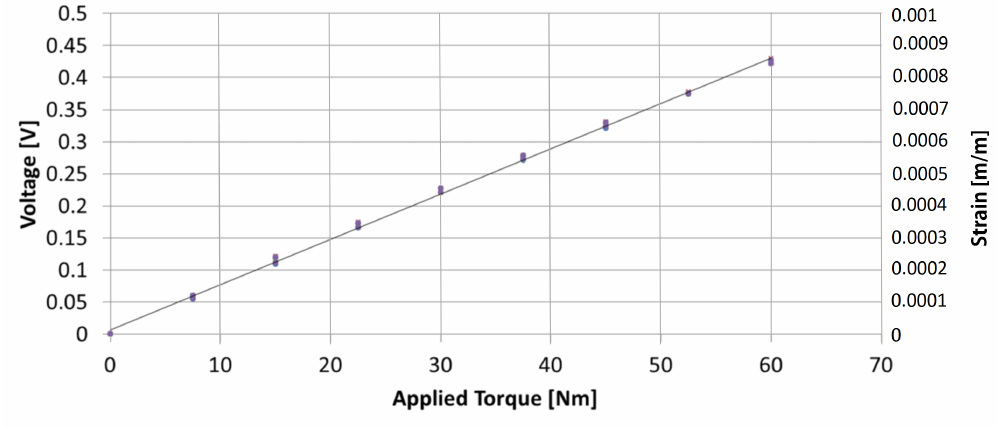
Figure 21. Calibration and regression